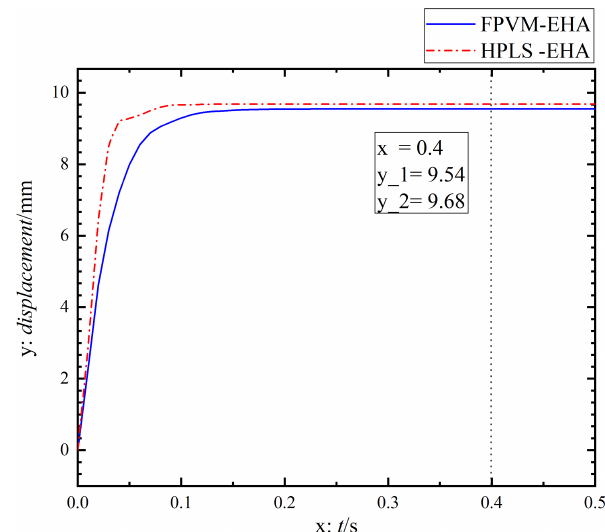
Figure 13. Contrast diagram of output position of actuator (0– 0.5s).